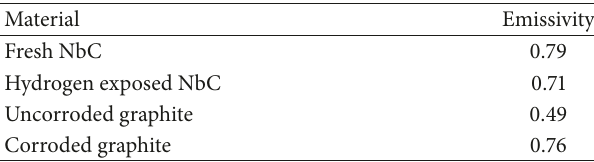
Table 3: Emissivity coefficients of fresh and corroded materials.